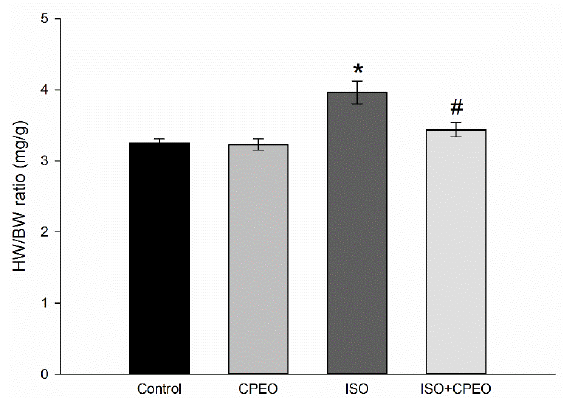
Figure 1. Effect of Cymbopogon proximus essential oil (CPEO) on body weight (BW) and heart weight (HW) of rats. Male albino rats were injected intraperitoneally daily with vehicle (saline + olive oil) as the control, CPEO (800 µ L / kg / d), isoproterenol (ISO; 5 mg / kg), or CPEO (800 µ L / kg / d) plus isoproterenol (5 mg / kg). CPEO administration was started 4 d prior to isoproterenol administration and continued concurrently thereafter for an additional 3 d. The HW / BW ratio (mg / g) was determined for each animal after 7 d of treatment with vehicle, CPEO, ISO, or a combination of ISO + CPEO. The results are presented as the means of six independent experiments ± SEM. * p < 0.05 compared to control, # p < 0.05 compared to ISO-treated